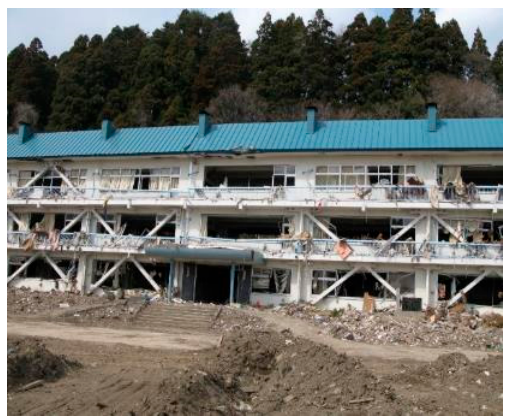
Figure 24. Reinforced concrete building, inundation depth 8.5 m, Rikuzentakata City.